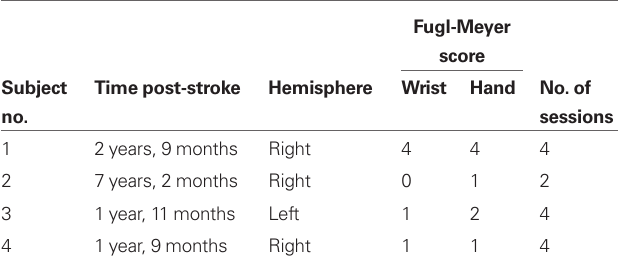
Table 1 | Study participant